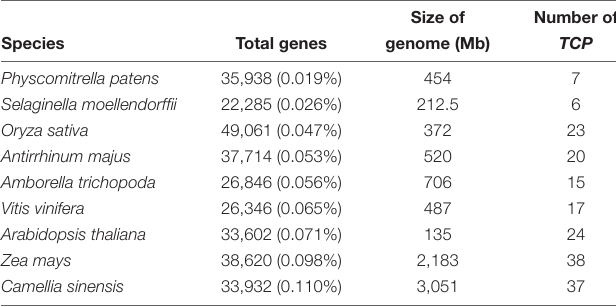
TABLE 2 | The TCP transcription factors in genomes of nine species.